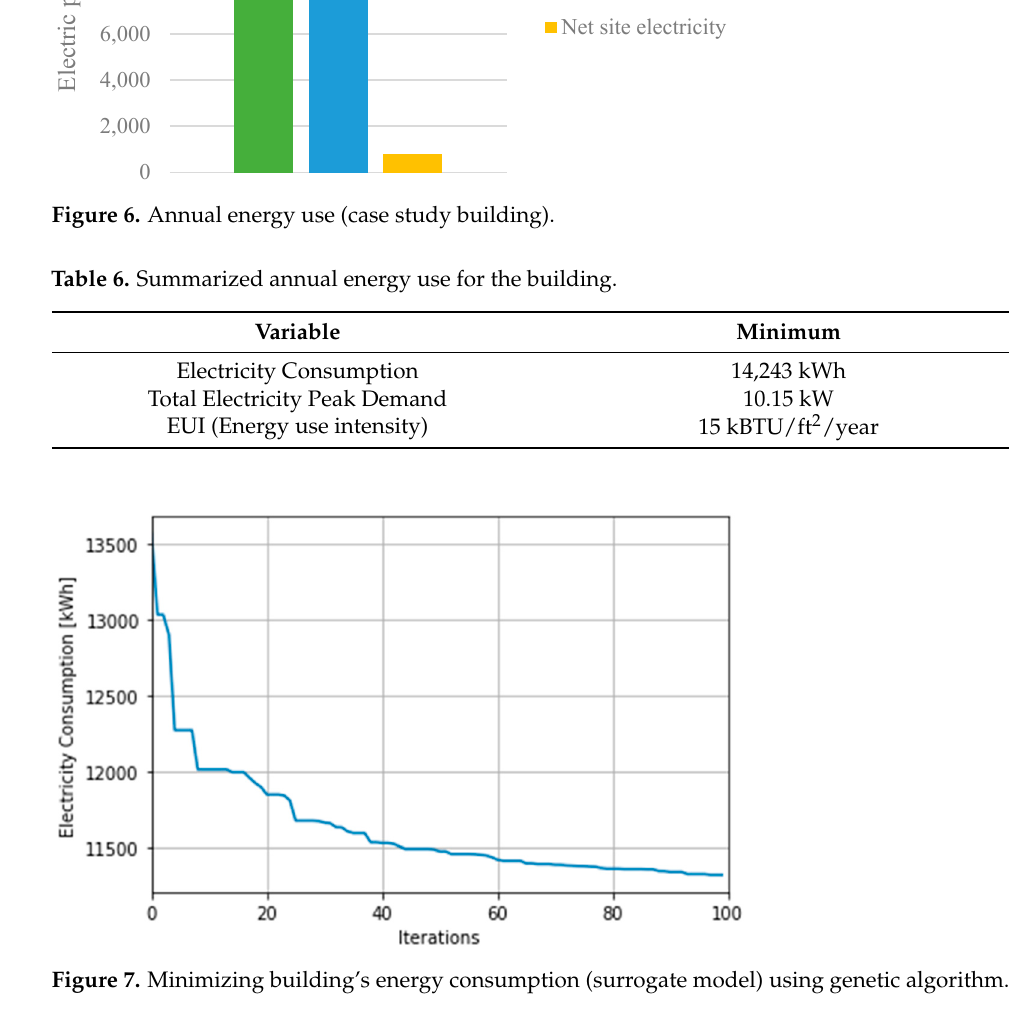
Table 6. Summarized annual energy use for the building.